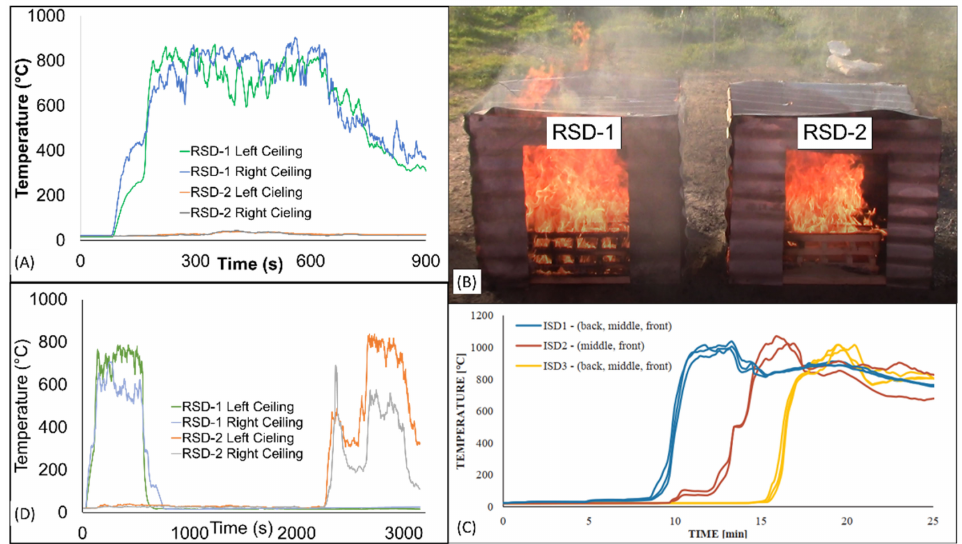
Figure 6. Longitudinal fire spread results. Left top clockwise—( A ) Test 2: ceiling temperature on cross wind condition, ( B ) RSEs on steel-clad dwellings, ( C ) FSE results on steel-clad dwelling [7], ( D ) test 3: ceiling temperature on circular wind